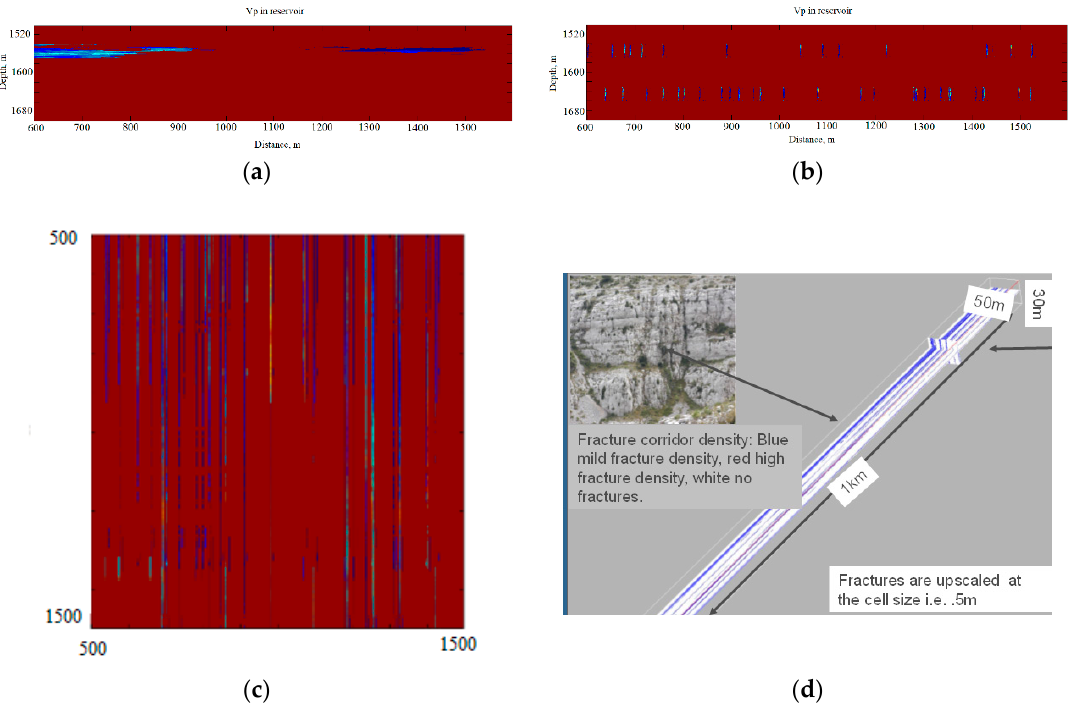
Figure 5. Sketch of the reservoir. ( a – c )—side and top views. ( d ) Upscaling of the fractures to fracture corridors.